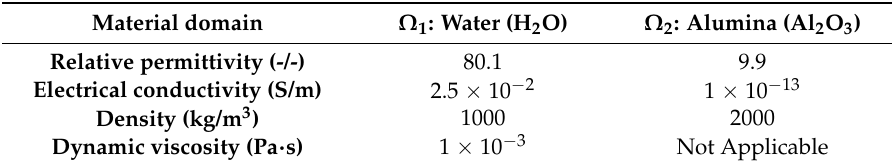
Figure 8. ( a ) Schematic of COMSOL TDE model; ( b ) Generated mesh ( left ) with the expanded detail of generated mesh in the particle’s vicinity ( right ). Table 2. Material Properties used in the single particle 2D model.